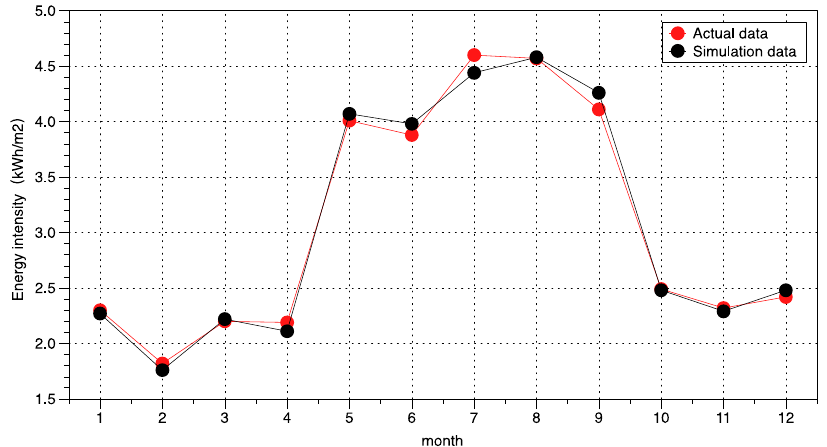
Figure 10. Comparison of calibrated simulated energy consumption with measured data.